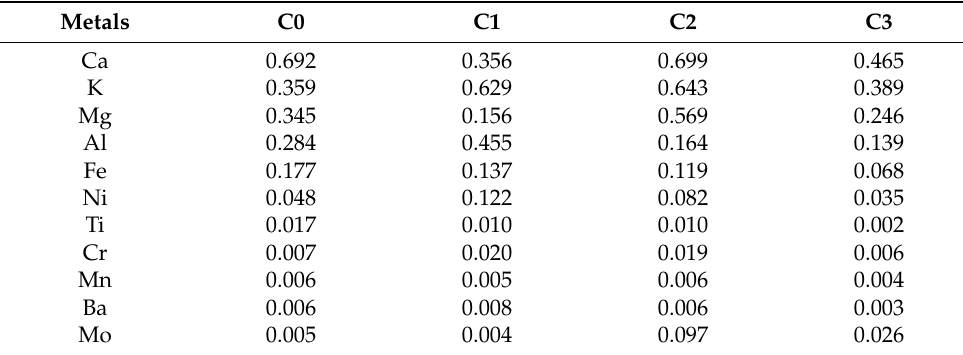
Table 5. The percentages (%) of major ash–forming metals in